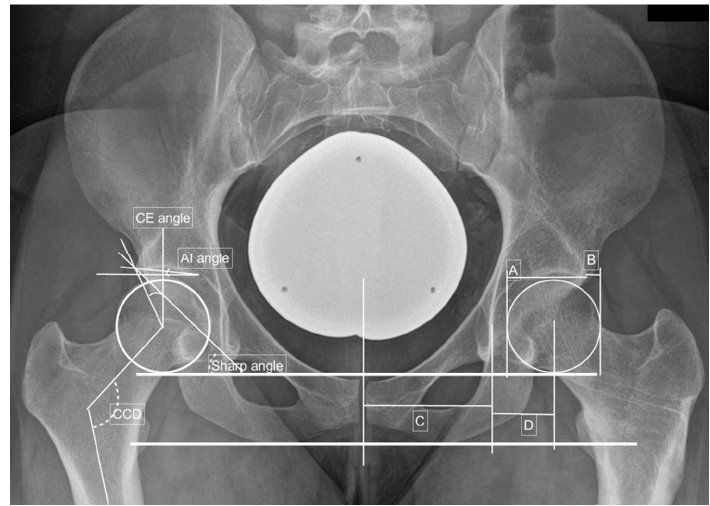
Figure 2. Preoperative measurements in a right-sided borderline dysplastic hip: CE angle—23.4°; AIA—4.9°; sharp angle—40.0°; hip lateralization—0.51; anterior hip index—82.8; CCD angle— 121.0°. Adopted from [14,15].